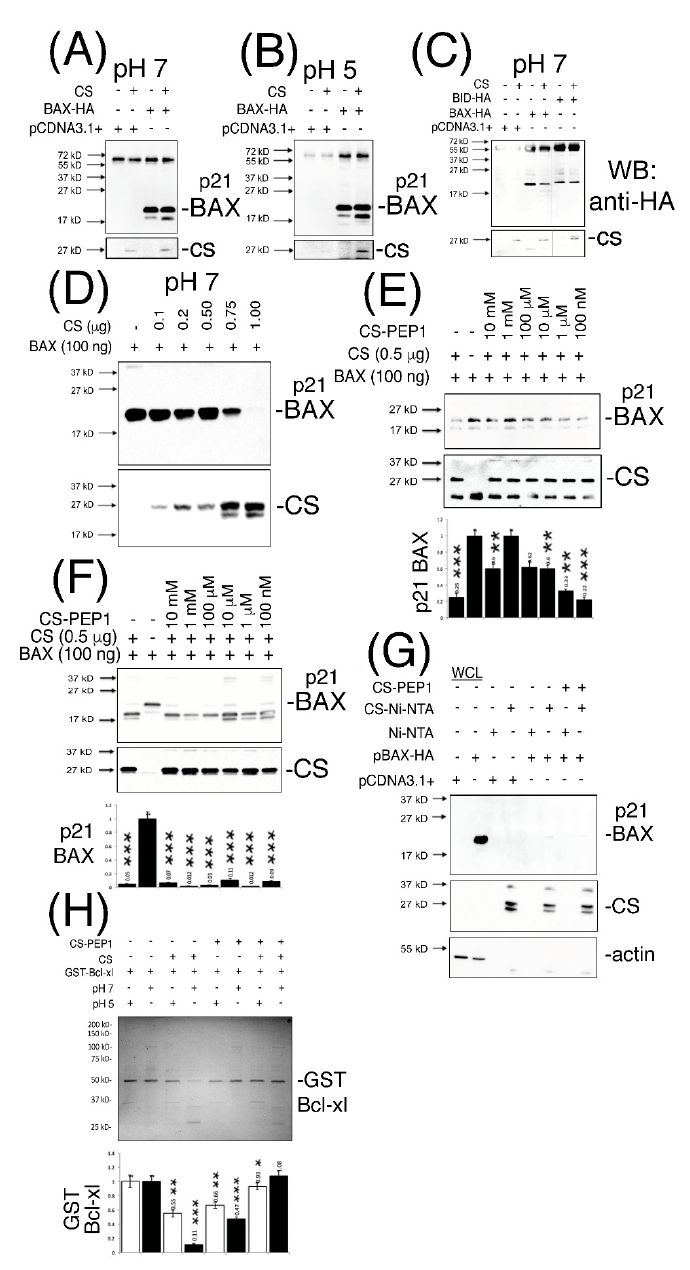
Figure 3. Active CS cleaves p21 BAX and GST-Bcl-xl in vitro and is inhibited by peptide CS-PEP1 in a pH-dependent manner. (Panels A – C ), Equal cleared cell lysate volumes from HEK293 cells ex- pressing BAX-HA or BID-HA for 24 h were immunoprecipitated using an anti -HA antibody, and washed immunoprecipitates exposed to active CS at pHs 7 and 5. Cleavage products were detected by Western blotting (top panels) and filters were re-probed to detect CS (lower panels). (Panel D ),